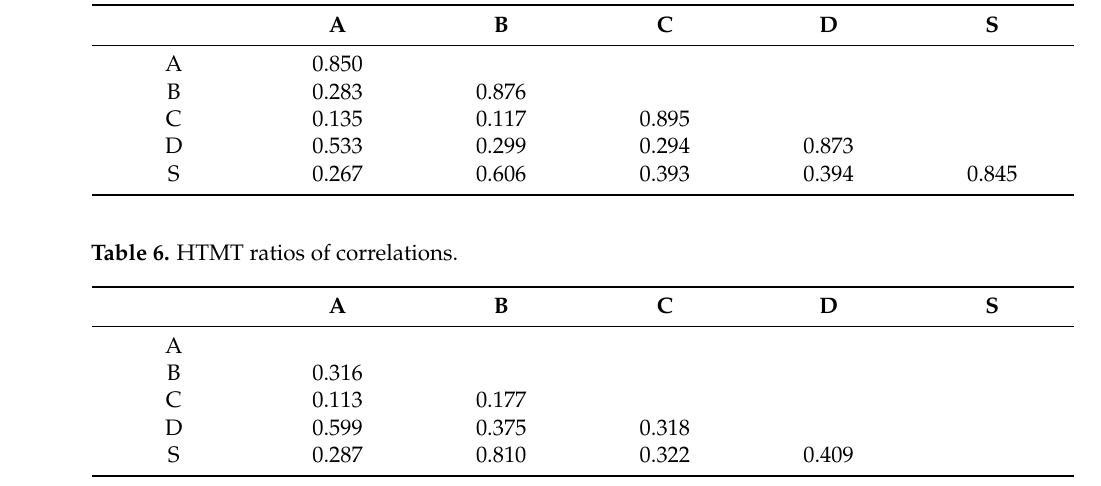
Table 5. Discriminant validity analysis based on Fornell-Larcker criterion.